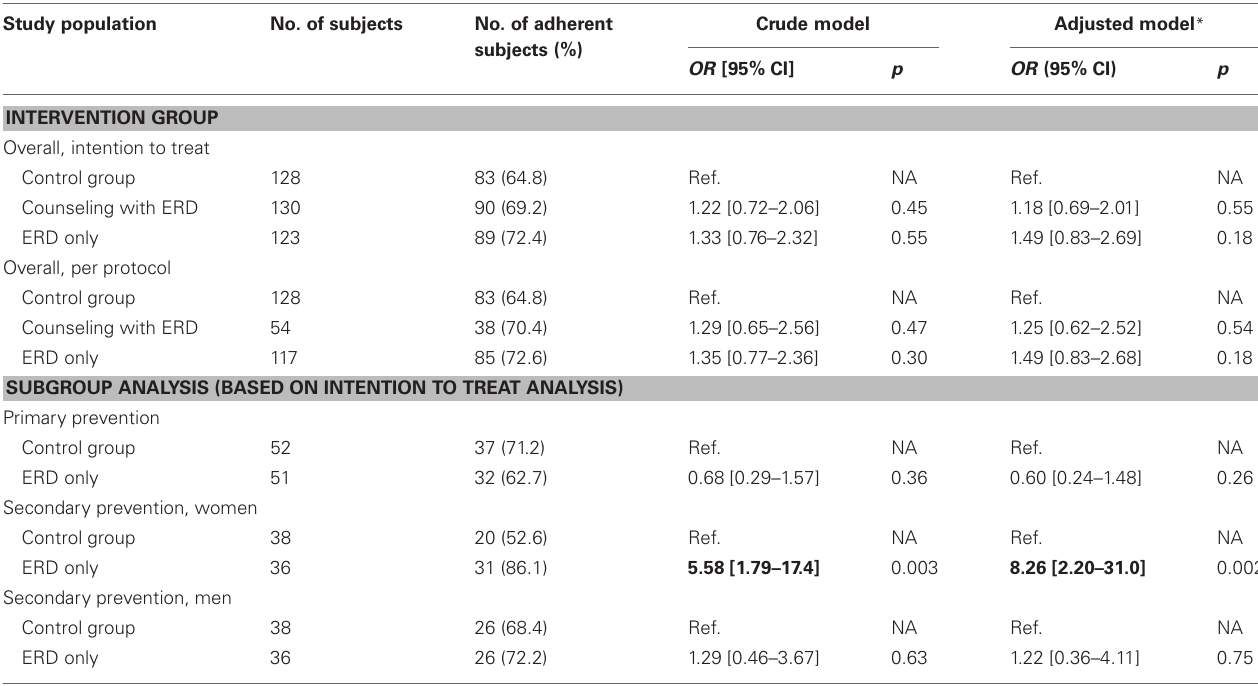
Table 2 | Results of multilevel analyses of the effectiveness of the interventions on proportion of adherent patients (PDC360 >